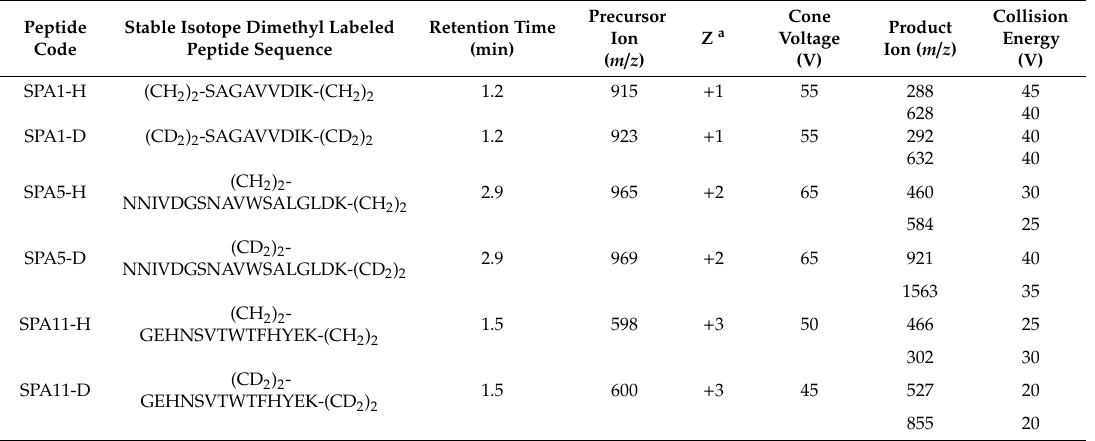
Table 1. The parameters of LC-MS-MRM analysis for dimethyl-labeled peptides.